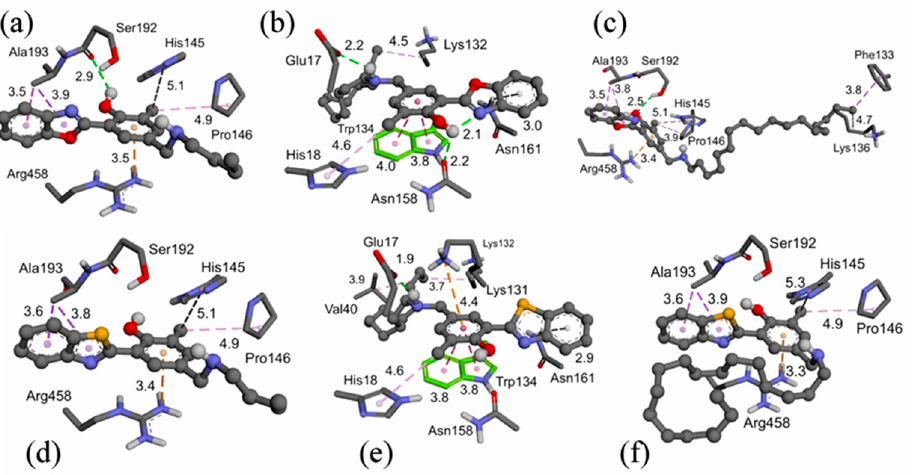
Figure 9. Interactions between the compounds ( a ) 12 ; ( b ) 13 ; ( c ) 14 ; ( d ) 15 ; ( e ) 16 , and ( f ) 17 and the main residues of the BSA protein. Distances are presented in Å.